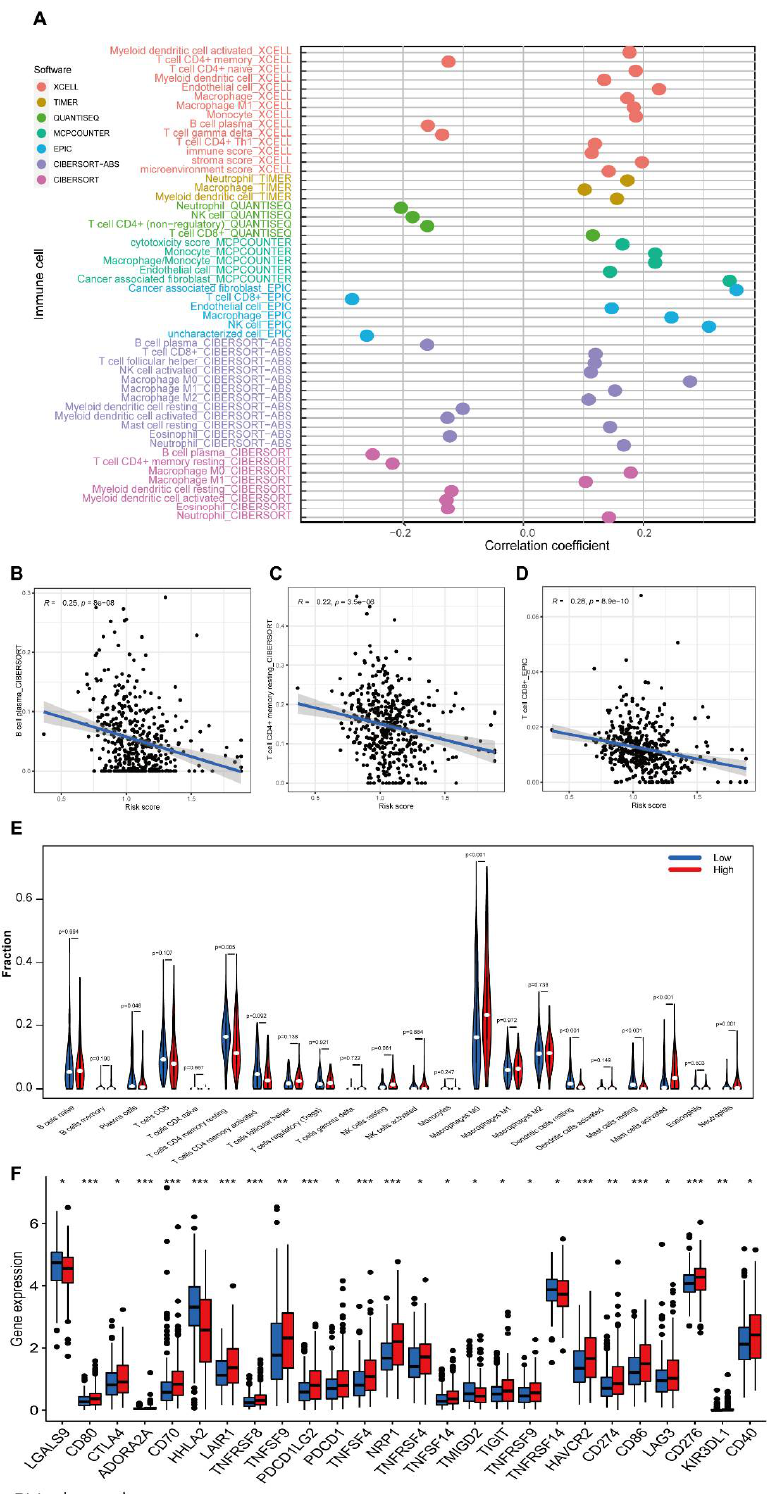
Figure 7. Assessment of the immune landscape in CRC patients. ( A ) A bubble chart shows many immune cells in risk groups using different types of software. ( B – D ) Three representative correlations between immune cell levels (B cells, CD4 + T cells and CD8 + T cells) and the risk scores. ( E ) Violin plots depicting the difference in the levels of twenty − two immune cells between the two risk subgroups of CRC patients. ( F ) Boxplots illustrating the levels of 26 immune checkpoint genes in two risk subgroups of CRC patients. *: p < 0.05, **: p < 0.01, and ***: p < 0.001, ns: no